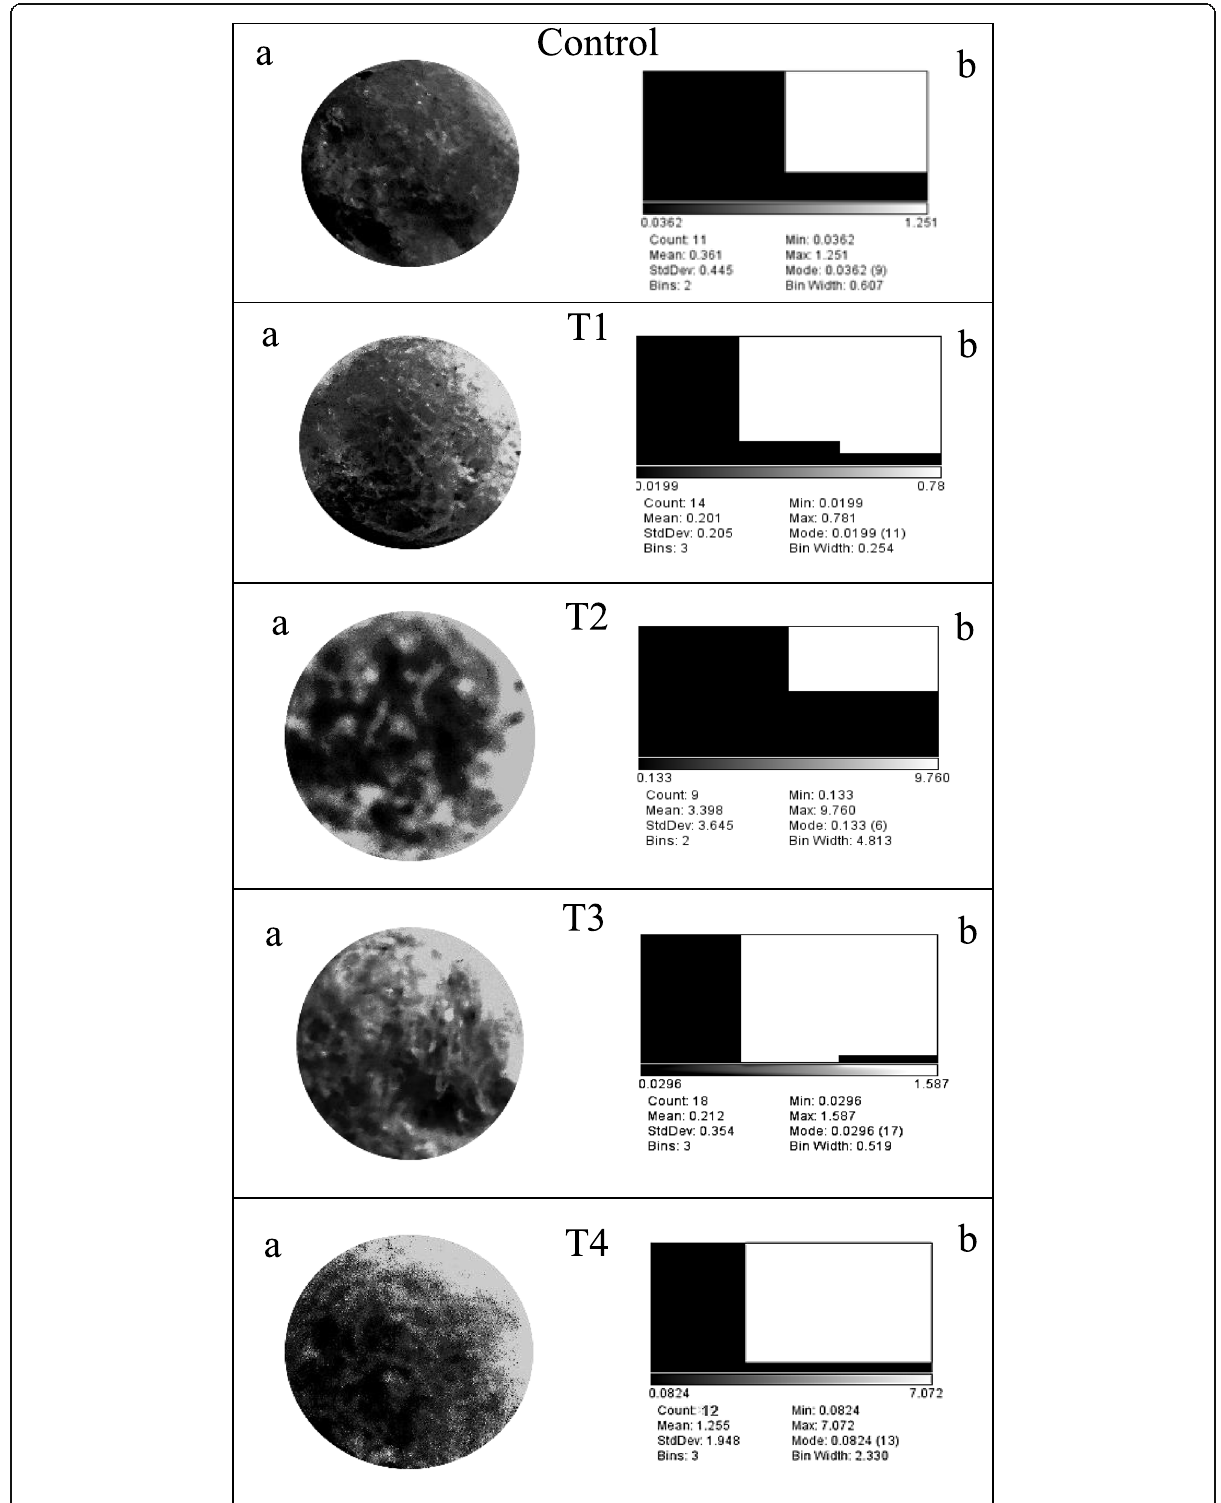
Fig. 5 The cross section analysis. (a): The cross section of the extruded product. (b): The area distribution of the cells. Control: plain extruded product. T1, T2, T3 and T4: extruded corn products fortified with 3% (w/w) of laurel, turmeric, ginger and mixture formula contains 3% of mix of the three herbs used (1:1:1),